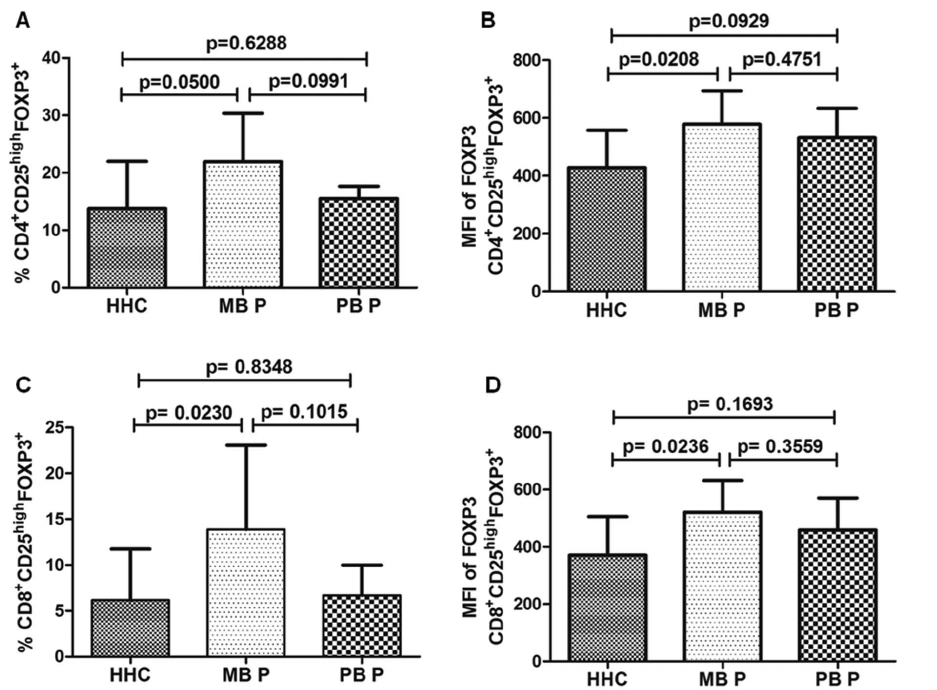
Figure 2. The frequency of CD4 + /CD8 + CD25 high FOXP3 + cells and FOXP3 mean fluorescence intensity (MFI) in leprosy patients and contacts. The frequency of Treg in CD4 + or CD8 + lymphocyte gate after 72-hour culture of peripheral blood mononuclear cells with anti-CD3 and anti-CD28 associated with total sonicated fraction of M. leprae. Comparison between household contacts (HHC), multibacillary patients (MB P) and paucibacillary patients (PB P), with regard to frequency of CD4 + CD25 high FOXP3 + (A) and CD8 + CD25 high FOXP3 + (C) cells and to FOXP3 MFI in CD4 + CD25 high FOXP3 + (B) and CD8 + CD25 high FOXP3 + (D) cells. Unpaired two-tailed Student t-test, p # 0.05 was considered significant. Results are presented as mean with